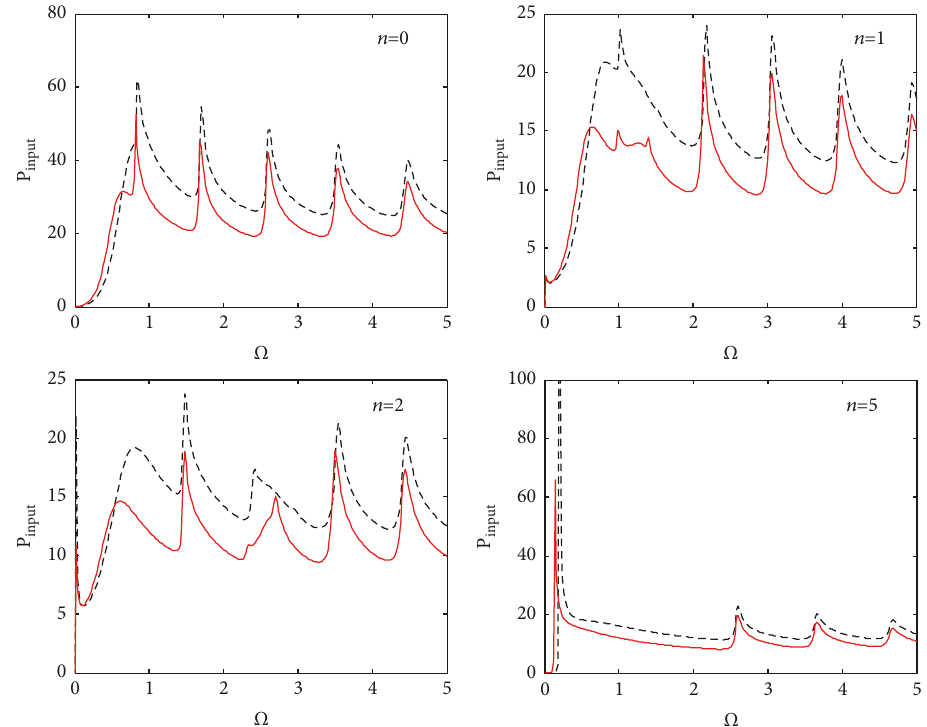
Figure 5: The comparison of nondimensional input power flow into the shell with different cross-ply: black dashed line: [90 ∘ /0 ∘ /90 ∘ ]; red solid line: [0 ∘ /90 ∘ /0 ∘